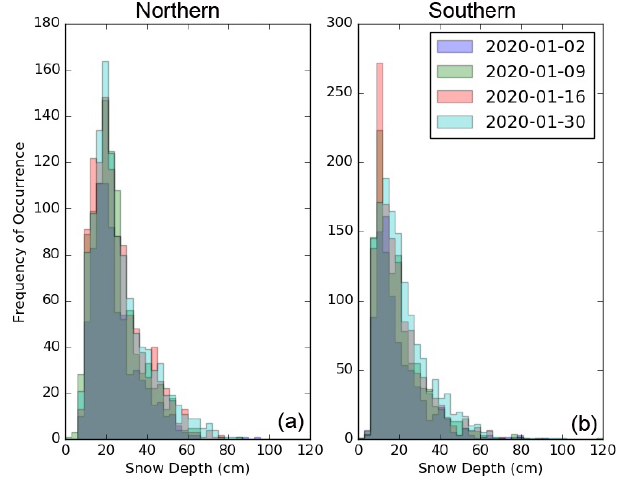
Figure 5. Snow depth distribution during January 2020 along the northern (a) and southern (b) transect loops.